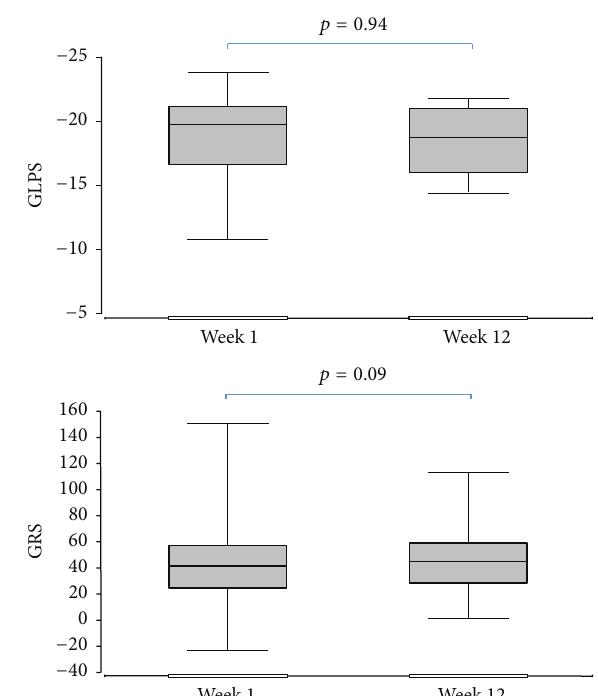
Figure 3: Global longitudinal peak systolicstrain (GLPS) and global radial strain (GRS) before and after weight